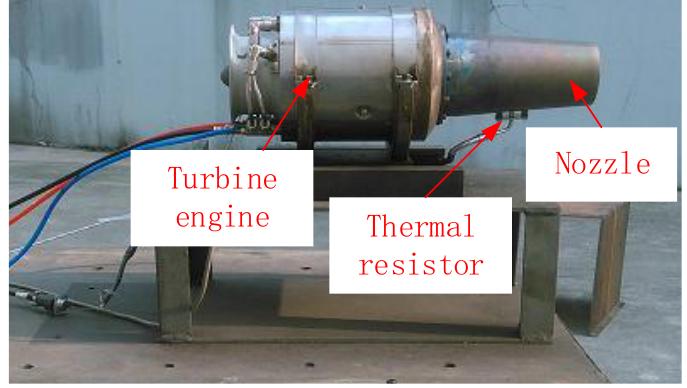
Figure 1. The unmanned aerial vehicle (UAV).